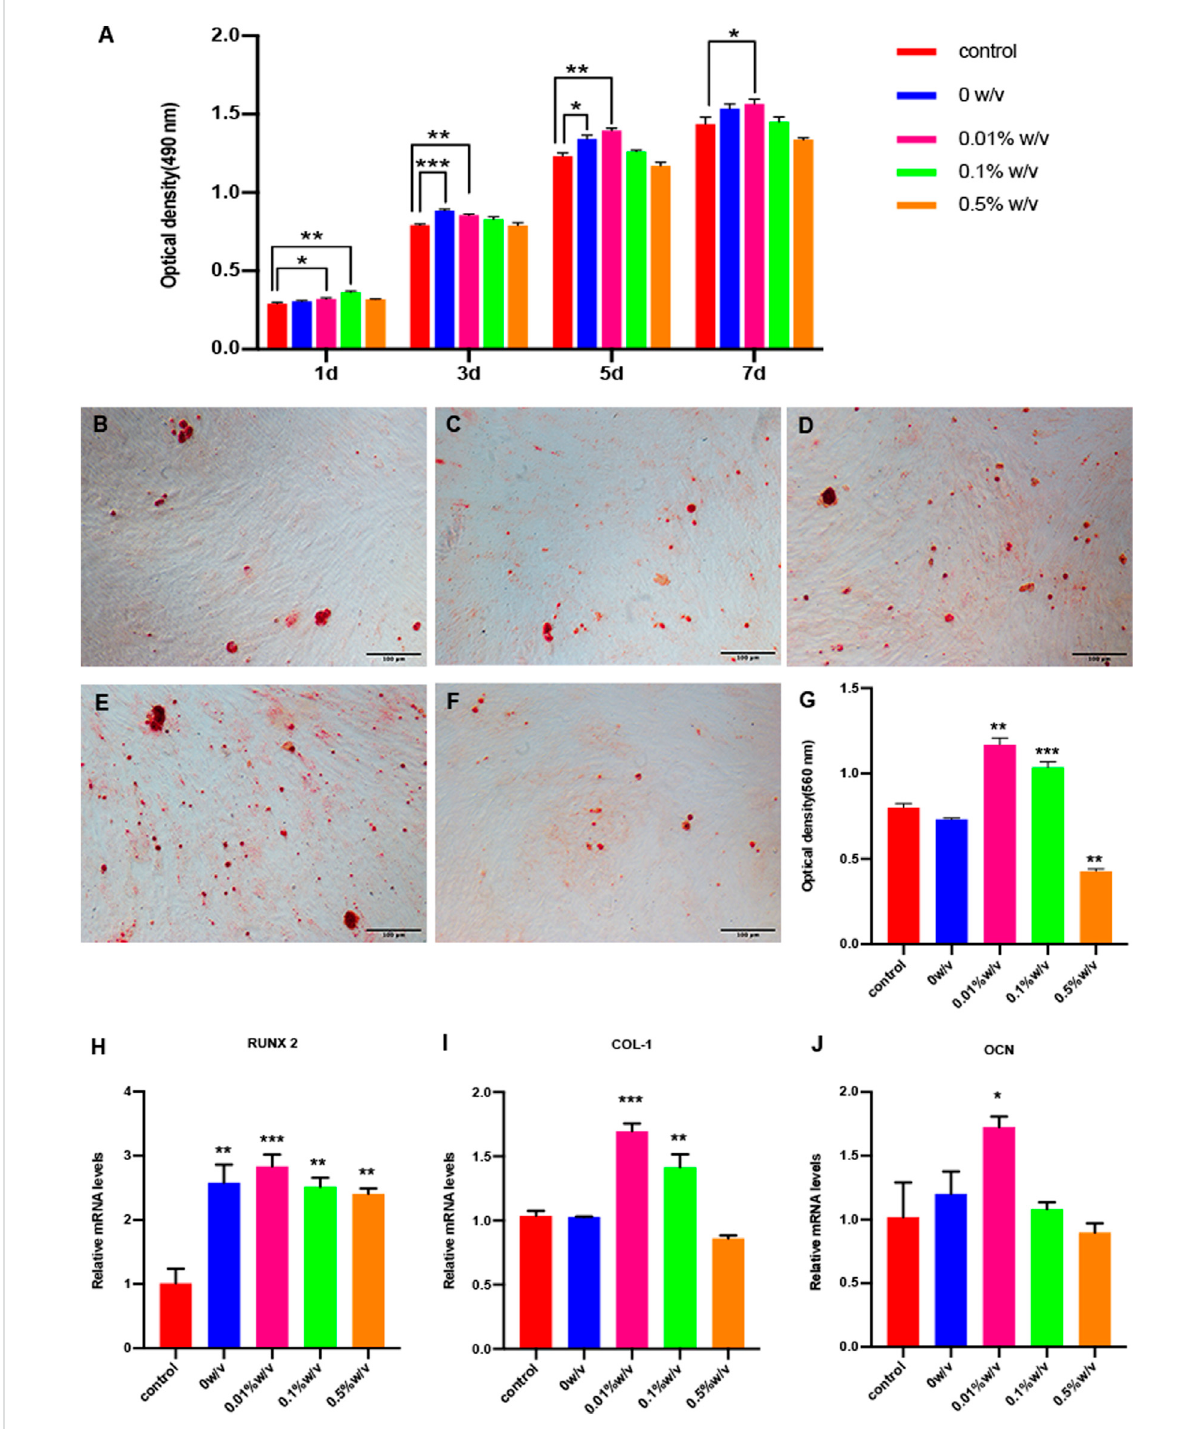
FIGURE 4 (A) Cell proliferation and cytotoxicity assay of SHEDs by CCK-8; Alizarin red staining of (B) Control group (C) 0w/v group (D) 0.01w/v group (E) 0.1%w/v group and (F) 0.5%w/v group (G) Semi quantitative results of alizarin red staining; (H – J) Real time PCR results of osteogenic – speci fi c markers. (* p < 0.05, ** p < 0.01, *** p < 0.001. RUNX2: Runt related transcription factor 2, COL-I: Collagen I,OCN: